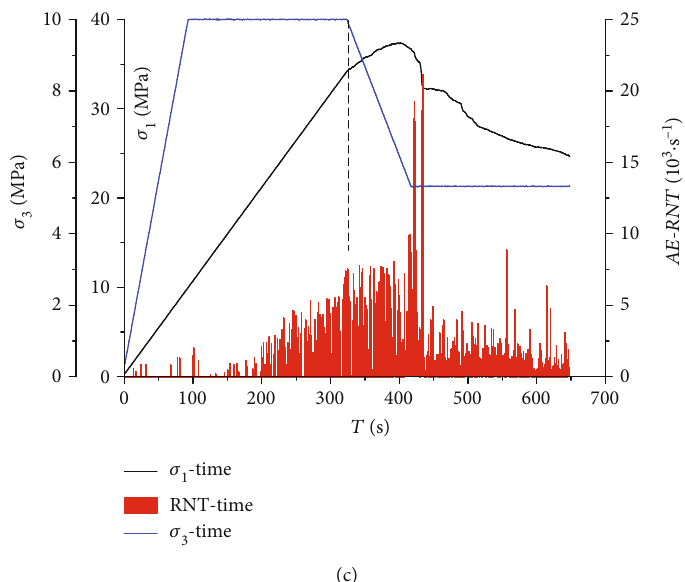
Figure 6: Test results of AE-RNT curves of rock samples under triaxial compression and unloading